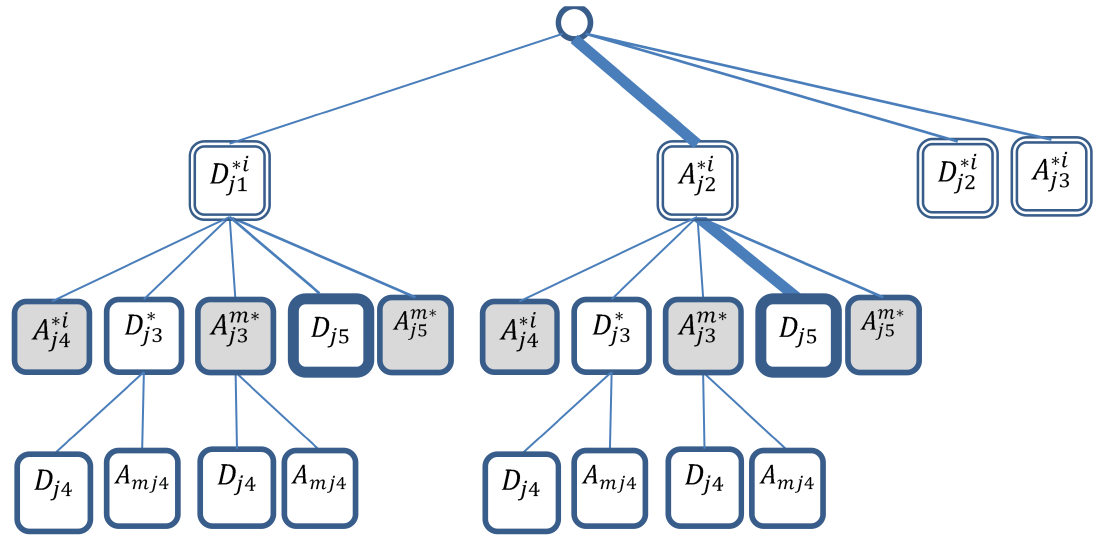
Figure 10. Tree of technological operation network cuts after conversion operations.